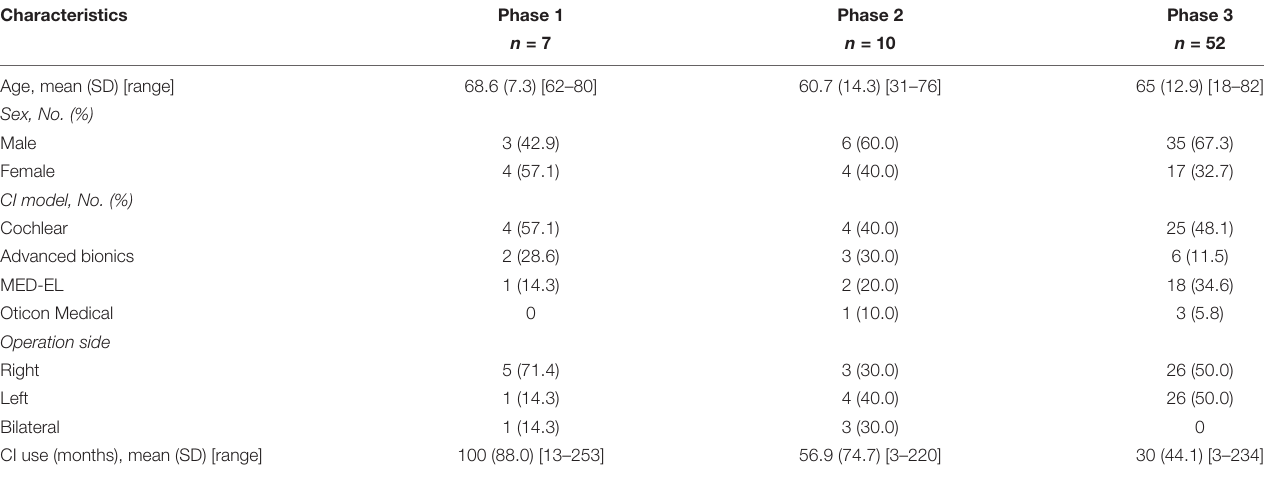
TABLE 1 | Characteristics of study participants per study